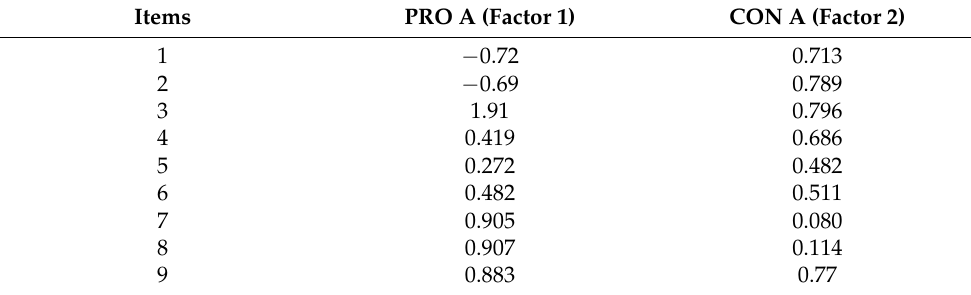
Table 4. Factor weights: principal component analysis.